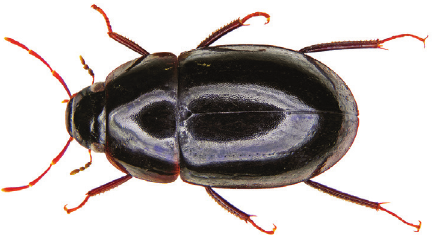
Figure 30. Helochares longipalpis (Murray, 1859) 7.0 mm, iSimangaliso Wetland Park, Catalina Bay (site 32), February 2015 DT Bilton, MS Bird & R Perissinotto leg.